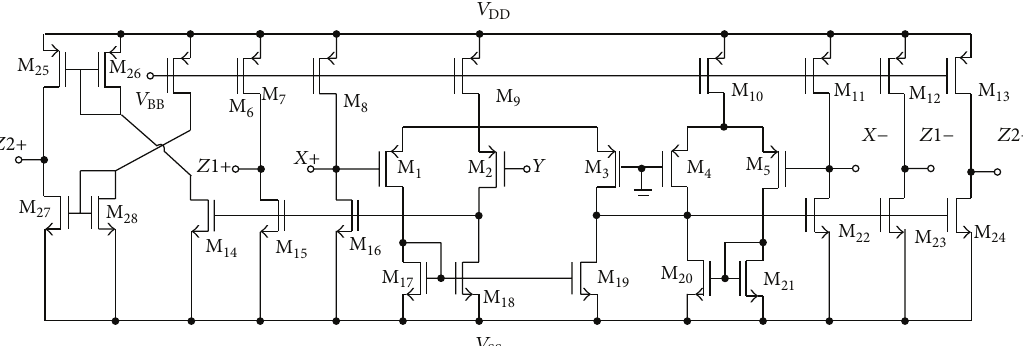
Figure 3: CMOS implementation of DX-MOCCII.